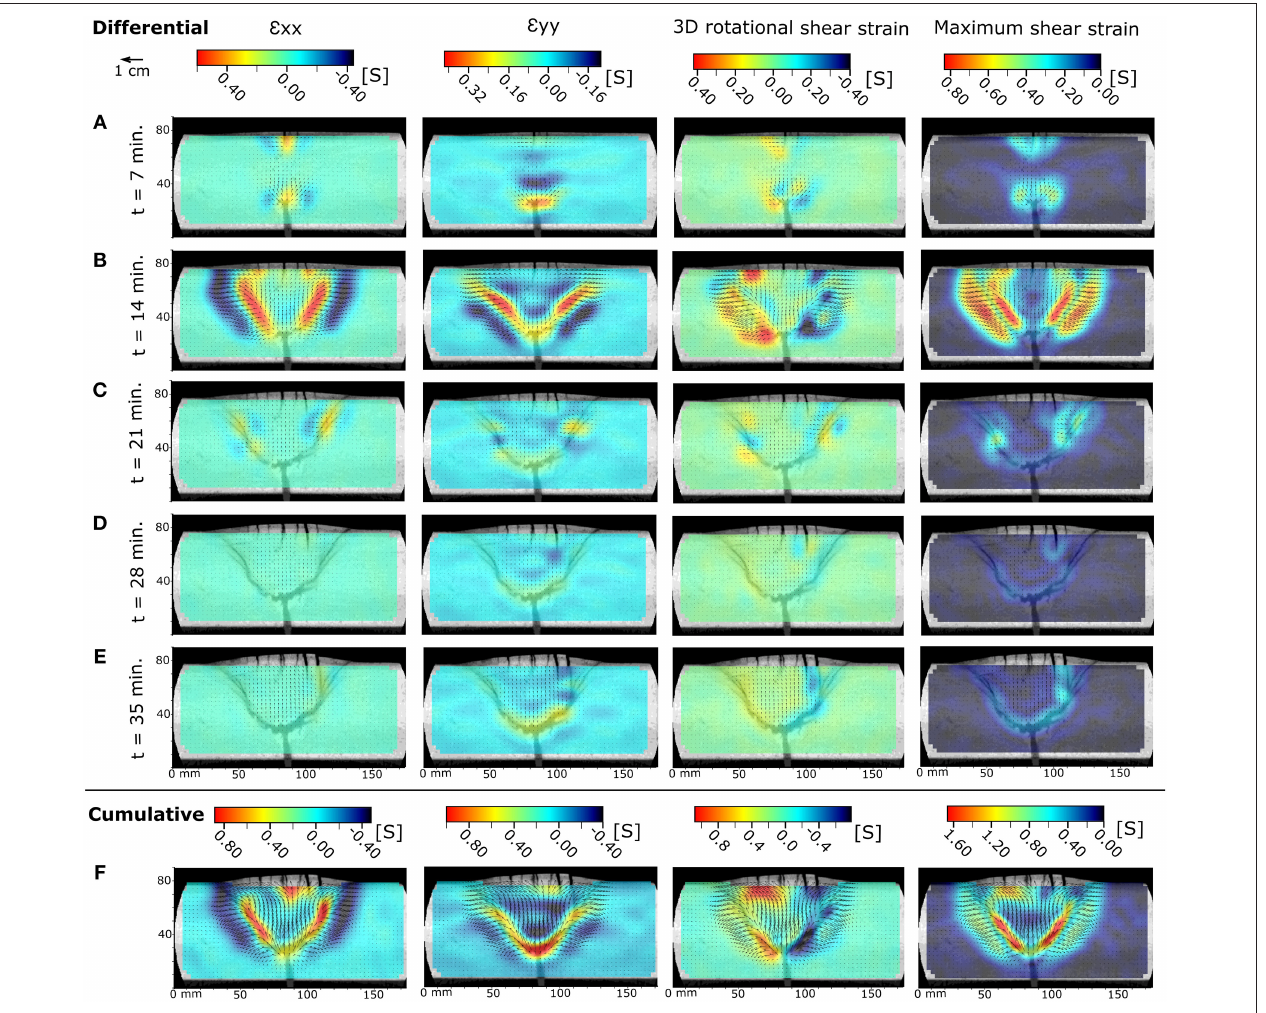
FIGURE 10 | DVC results for differential (A–E) and cumulative (F) host material deformation induced by a cone sheet intrusion in a 80:20 wt% sand:plaster mixture (SPCTIN06 in Table 2 )—arrows indicate magnitude and orientation of calculated displacement vectors: (Left column) Horizontal (longitudinal) strain, shortening is negative/blue; (Central left column) Vertical (axial) strain, shortening is negative/blue; (Central right column) Horizontal rotational shear strain around the z-axis, anticlockwise rotation is positive/blue; (Right column) Maximum shear